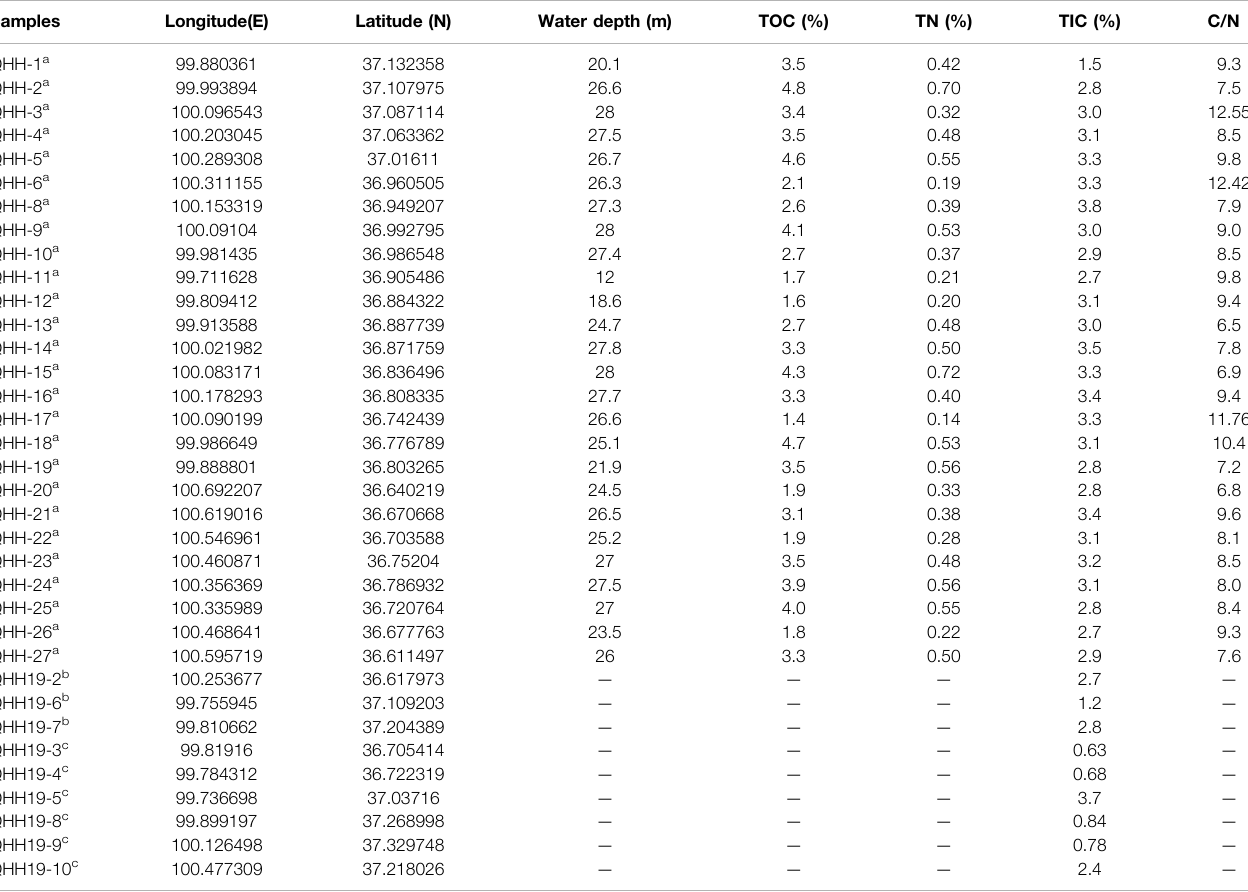
TABLE 1 | Location, water depth, total organic carbon content (TOC), total nitrogen content (TN), total inorganic carbon content (TIC), and atomic C/N ratio of sur fi cial samples. Samples Longitude(E) Latitude